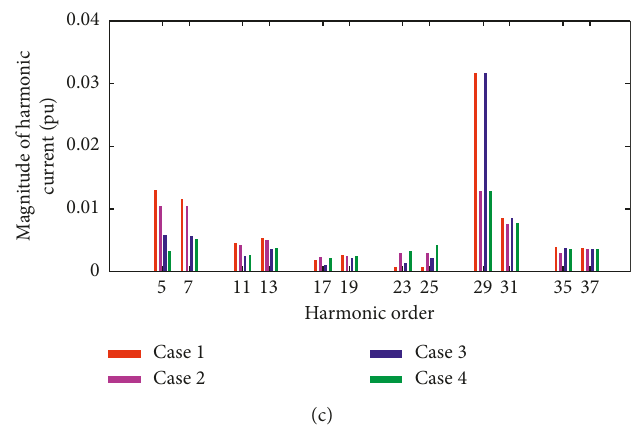
Figure 14: Harmonic current graphs of (a) i